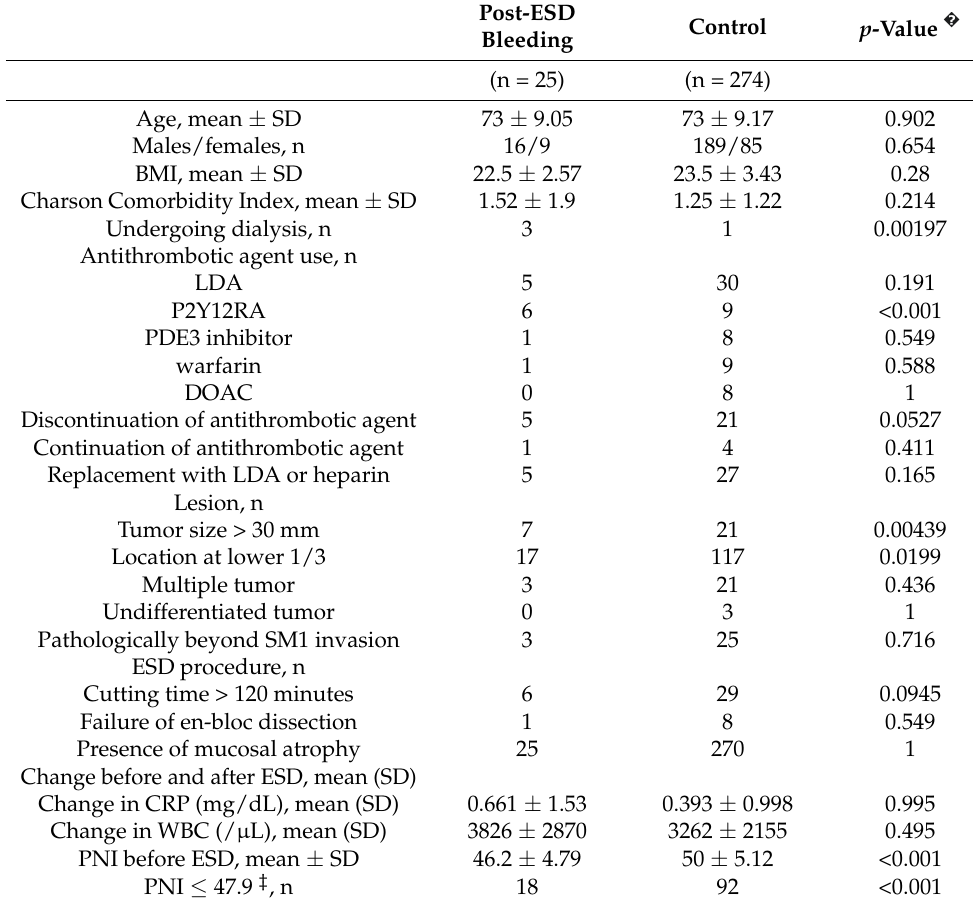
Table 1. Clinical features and characteristics in model cohort and validation